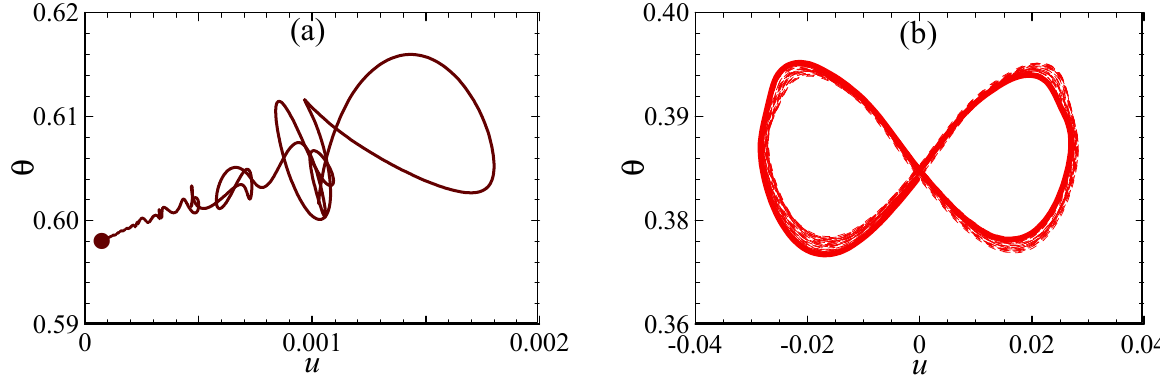
Figure 10. Limit point and limit cycle in the u– θ plane at the point P 4 (0.4, 0.51) for ( a ) Ra = 10 6 and ( b ) Ra = 10 7 .